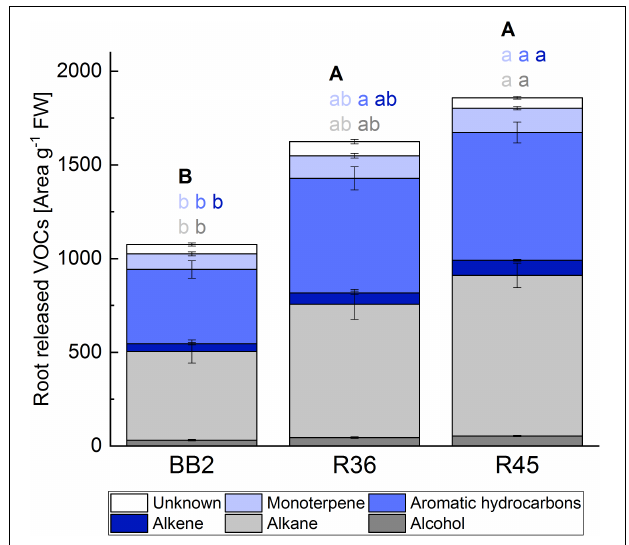
FIGURE 4 | Root-released VOCs from trees of three Q. robur populations ( N = 20). Data shown in Supplementary Table S6 were summarized according to main compound classes. Statistically significant differences between populations were calculated by Kruskal–Wallis-ANOVA ( p < 0.05) for each compound class and are indicated by different letters (individual colures represent the different compound classes).